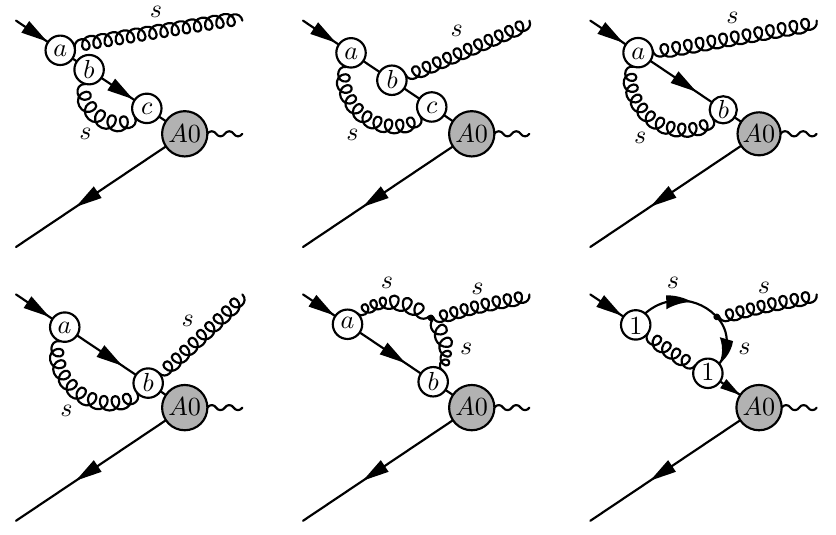
Figure 11 . Diagrams with one soft emitted gluon and one soft loop. Since all the diagrams here include the LP J A 0 ;A 0 current, the ( (cid:21) 2 ) power suppression must be provided by Lagrangian O insertions. This means using all possible insertions such that a + b (+ c ) = 2 at the indicated vertices. Out of the 20 possibilities, many vanish immediately due to contractions which yield n 2 = n (cid:6) (cid:13) ? = 0 or propagators which give zero due to the vanishing external transverse momentum. (cid:6) (cid:1) The remaining integrals, where the integrand does not immediately vanish, are either scaleless or vanish by Cauchy’s theorem, because all propagator poles lie in one half of the complex momentum plane.